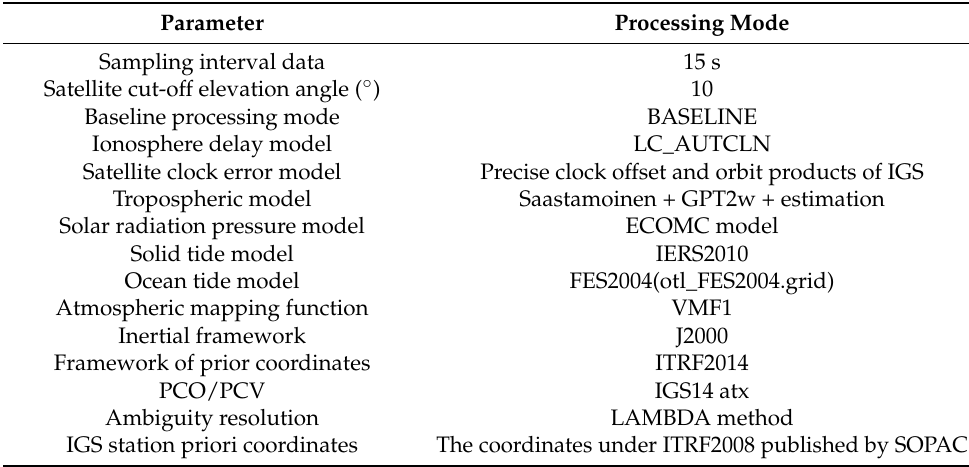
Figure 1. Location of CORS stations in southeast Zhejiang area. Table 1. The main parameters used in the GAMIT calculation.